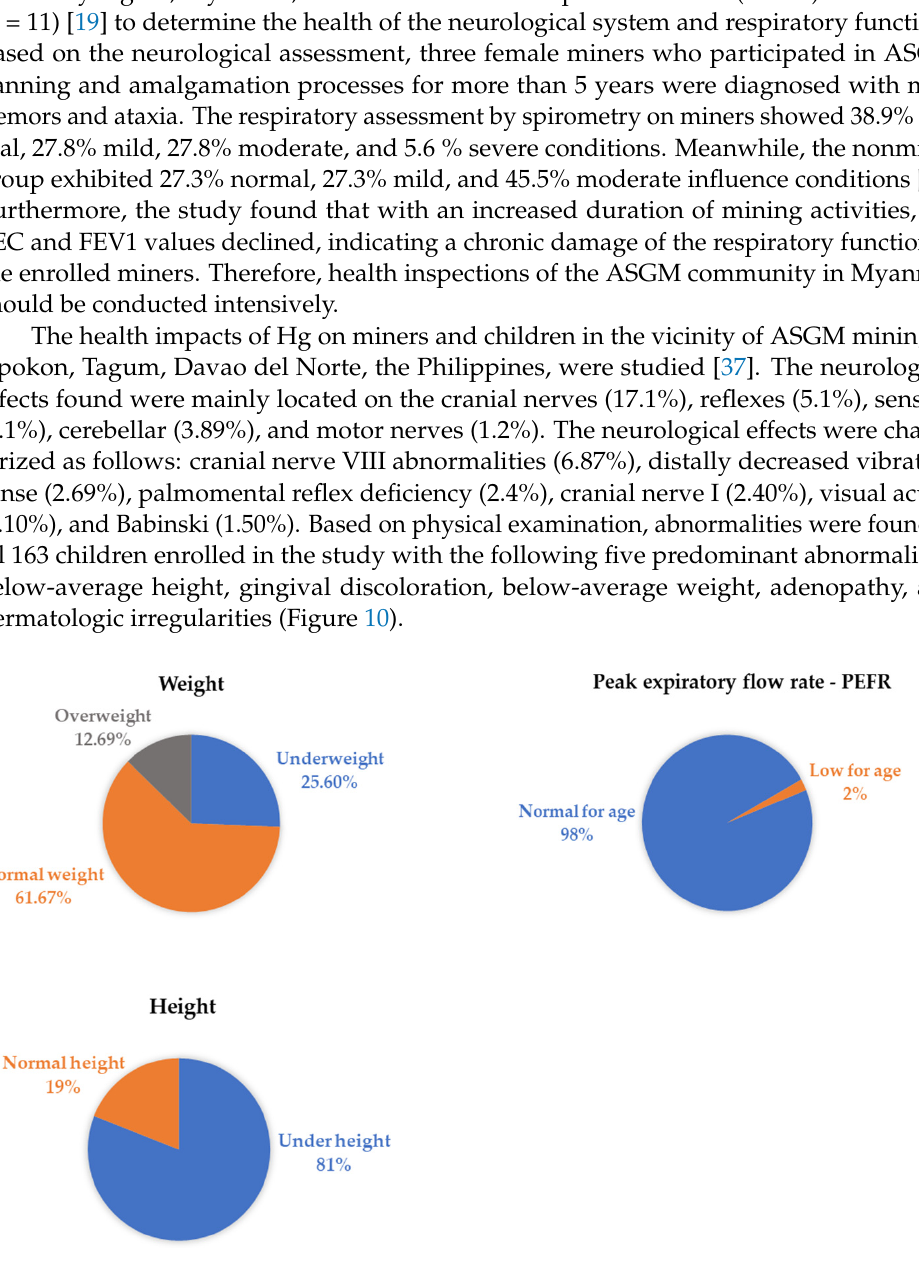
Figure 10. Predominant abnormalities found in schoolchildren of Apokon, Tagum, Davao del Norte, the Philippines [36].